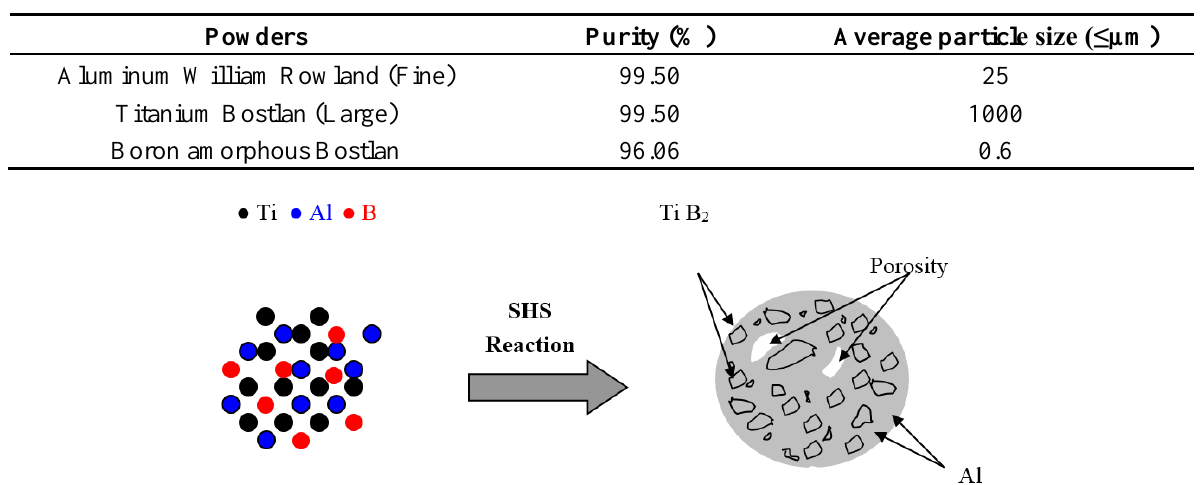
Table 1. Composition of elemental Ti and B powders.